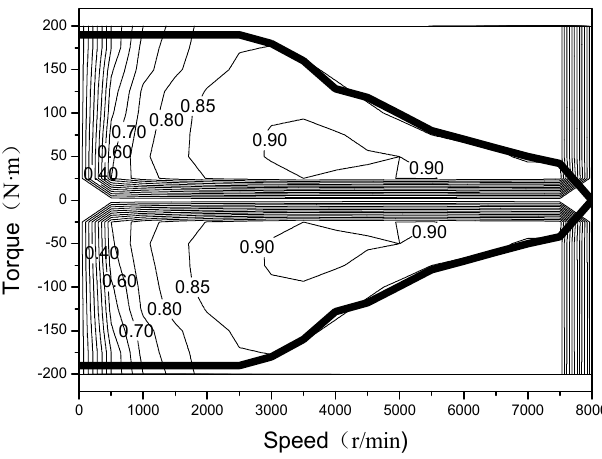
Figure 6. Motor efficiency map.